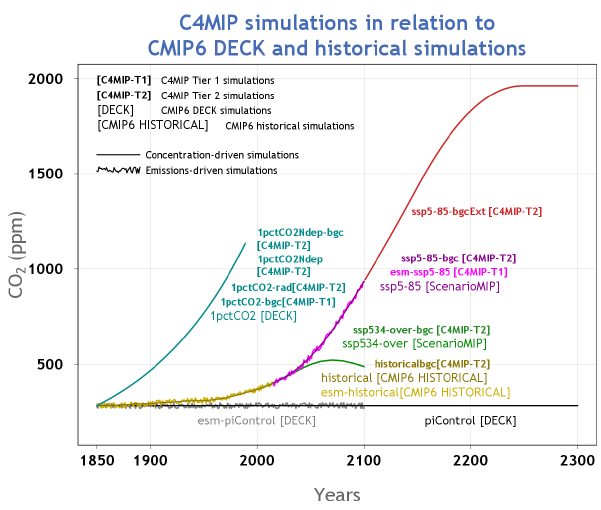
Figure 1. Relation of C4MIP simulations to CMIP6 DECK and his- torical simulations and the ssp585 and ssp5-34-over future scenario simulation proposed for the ScenarioMIP. Note that at the time of preparing this manuscript the details of the SSP5-3.4-OS-Ext exten- sion to 2300 are not available; hence, it could not be included in the figure, but it is still requested as a C4MIP tier-2